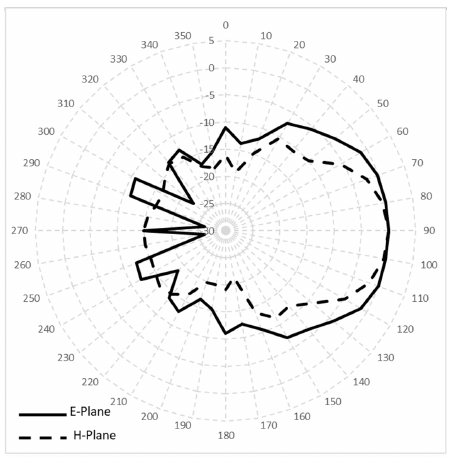
Figure 5. Radiation patterns of Vivaldi